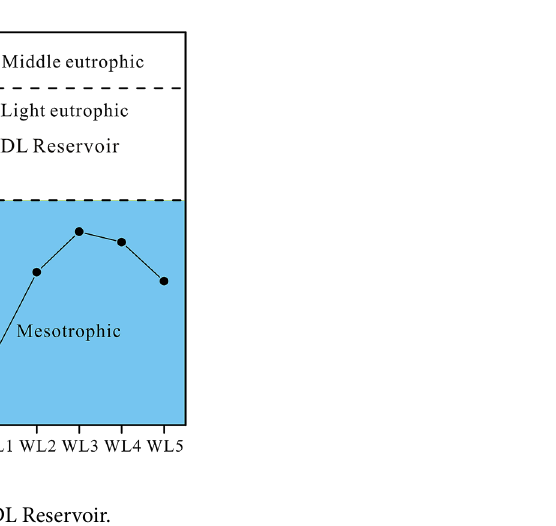
Figure 2. TSI values of WL Reservoir and DL